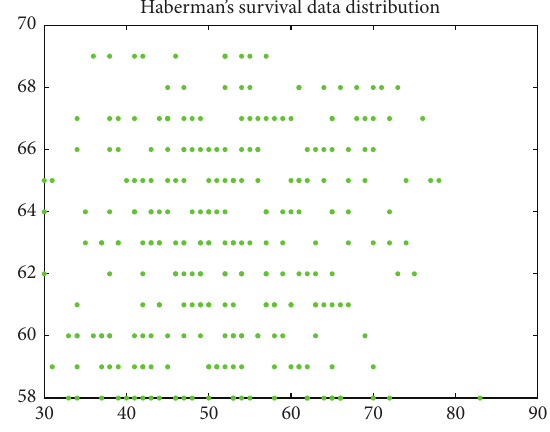
Figure 20: The survival data distribution.